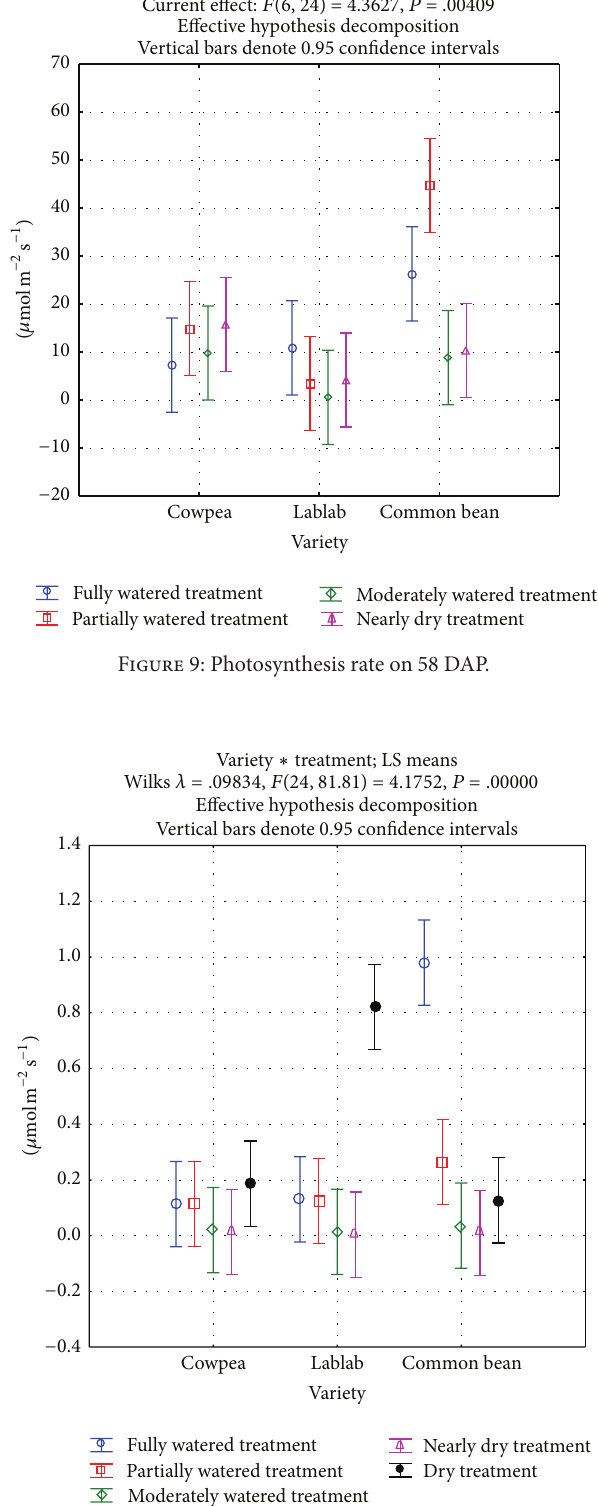
Figure 10: Stomatal conductance on 55